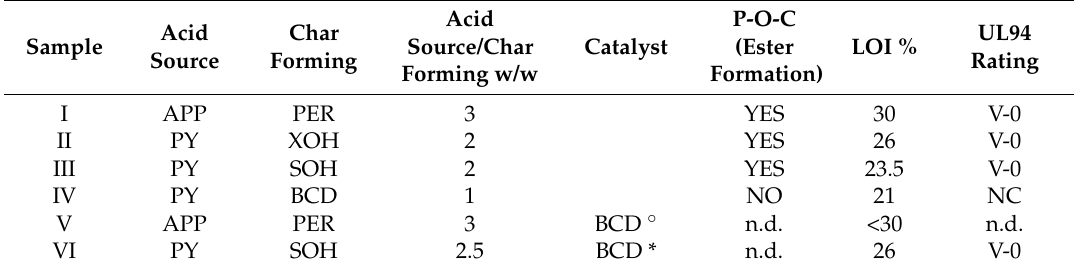
Table 1. Samples and fire retardance results for different char forming agent. Linear Low Density